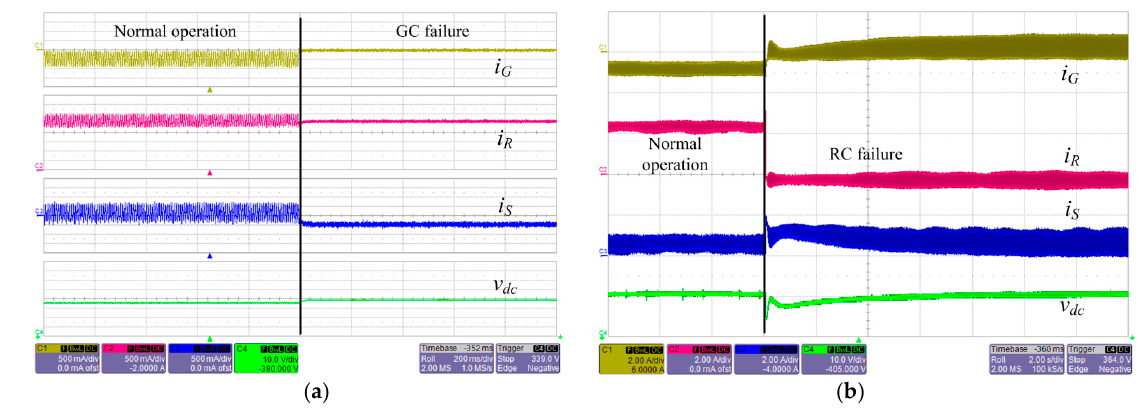
Figure 16. Failure modes of ( a ) GC; and ( b ) RC.